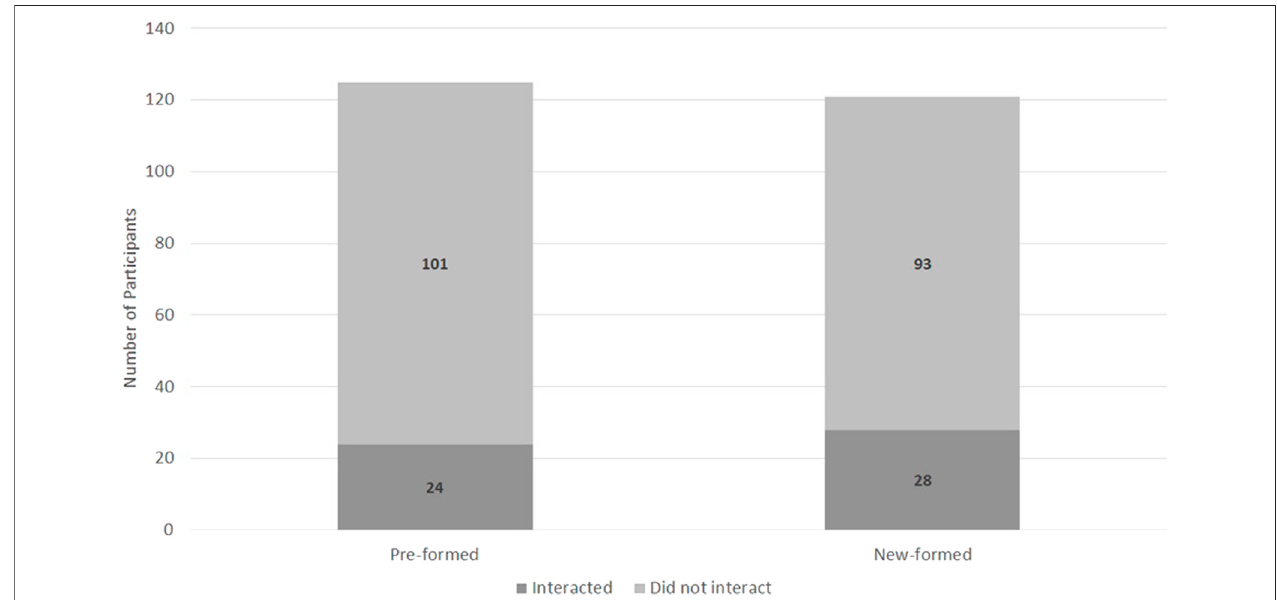
FIGURE 3 | A description of the results from